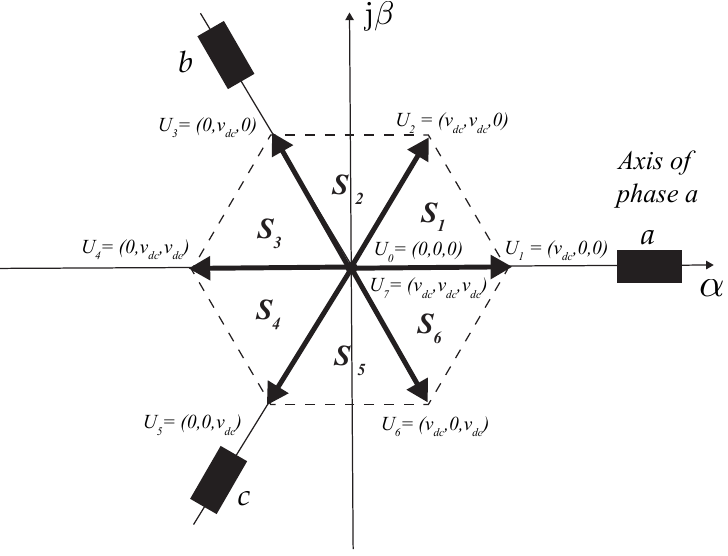
Figure 4. Standard vectors’ spatial disposition in the α